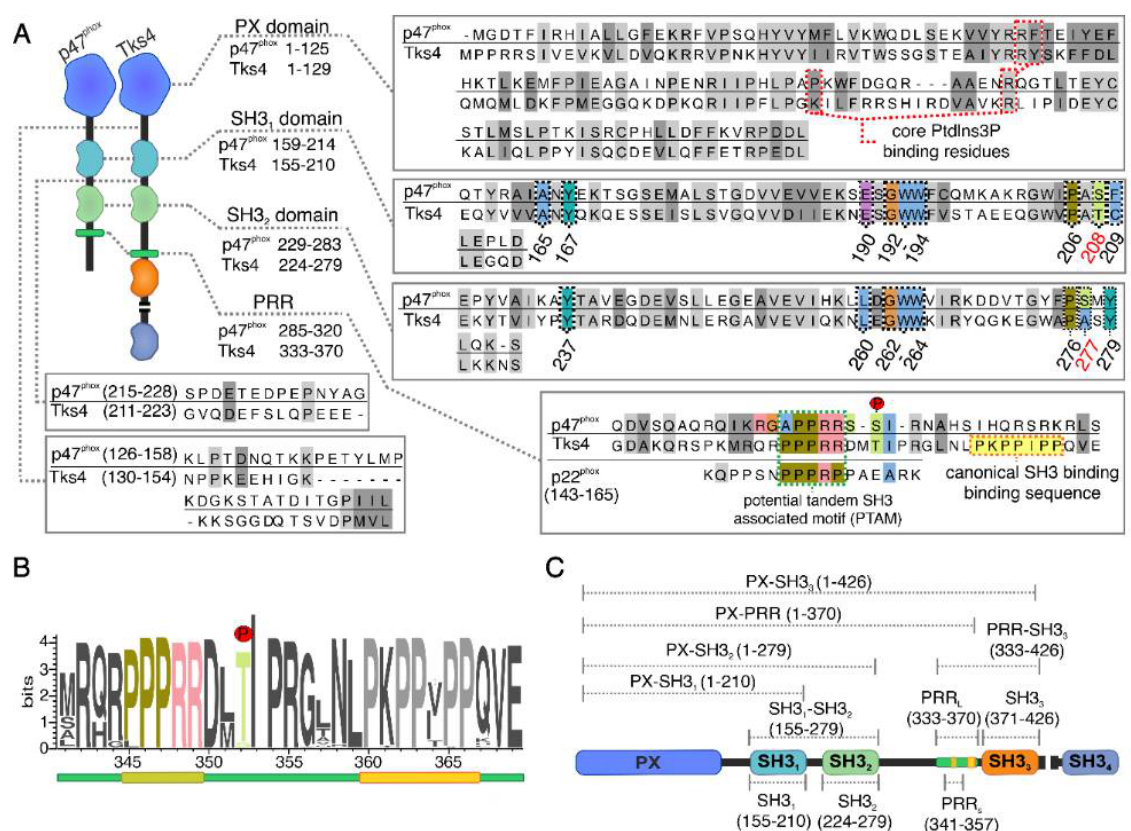
Figure 1. Tks4 and p47 phox show similarities in sequence and domain architecture. ( A ) Schematic representation of the domain architecture and sequence alignment of various regions of Tks4 and p47 phox . Identical and similar residues are highlighted in light and dark grey, respectively. Residues comprising the canonical PtdIns(3)P-binding pockets in the PX domains are highlighted in red dashed boxes. Critical residues comprising the binding pocket of the tandem SH3 domains and the SH3 1 –SH3 2 interface (black dashed boxes) are numbered. Ser208 and Ser277, important interacting sites in p47 phox (red numbers), are replaced by Thr and Ala, respectively, in Tks4. A tandem SH3-associated motif (PTAM) can be found in p47 phox , p22 phox , and in Tks4. However, the potential SH3 ligand found in Tks4 (yellow) is missing in p47 phox . Only a single regulatory phosphorylation site in p47 phox (Ser304) seems to be conserved in Tks4 (Thr353). ( B ) Alignment of the conserved regions containing the potential tandem SH3-associated motif (PTAM) in Tks4 proteins represented by a sequence LOGO. The schematic representation of the whole region (green) including the PTAM (PPPRR, pale green) and the potential SH3-binding motif (PKPP(V/I)PP, yellow) shown below the sequence is used in all figures throughout this work. The conserved threonine residue is the only known phosphorylation site in this region. ( C ) Tks4 fragments were used in this work. Domains were color coded in all schematic representations below, as shown in this